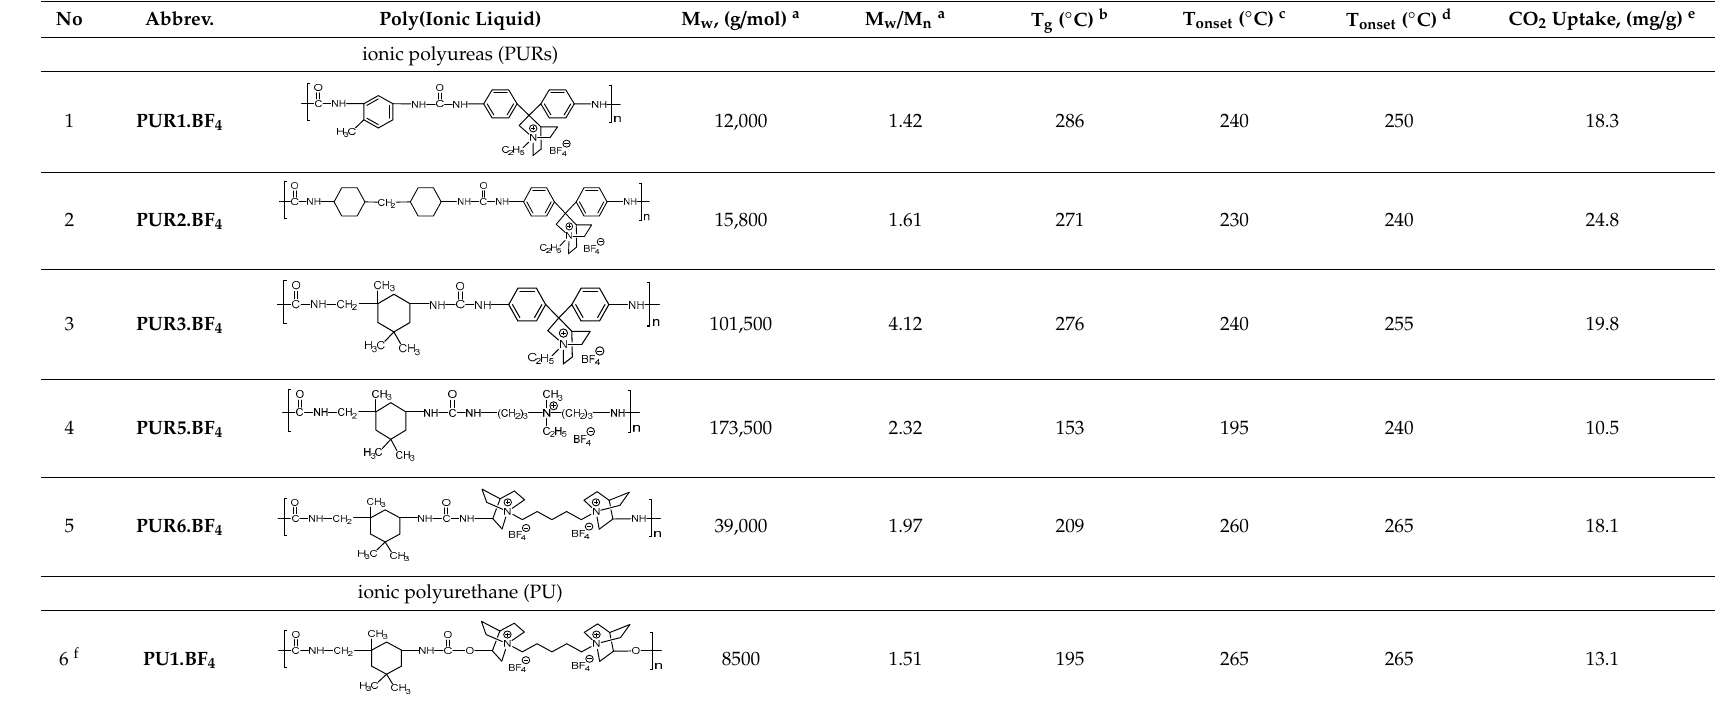
Table 1. Selected properties of ionic PURs and PUs.